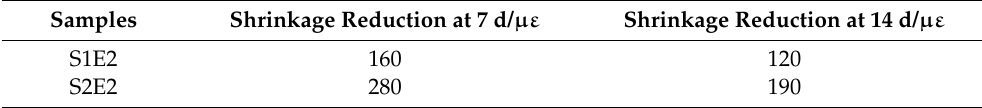
Table 5. Reduction in shrinkage of SAP and CEA in different periods.